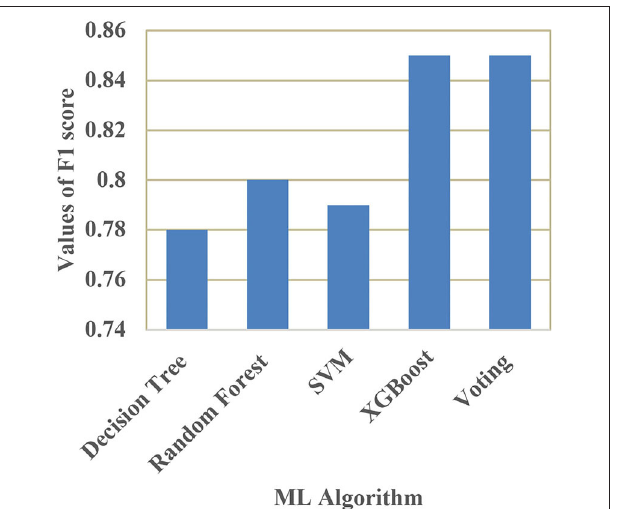
FIGURE 17 | Comparison of F1